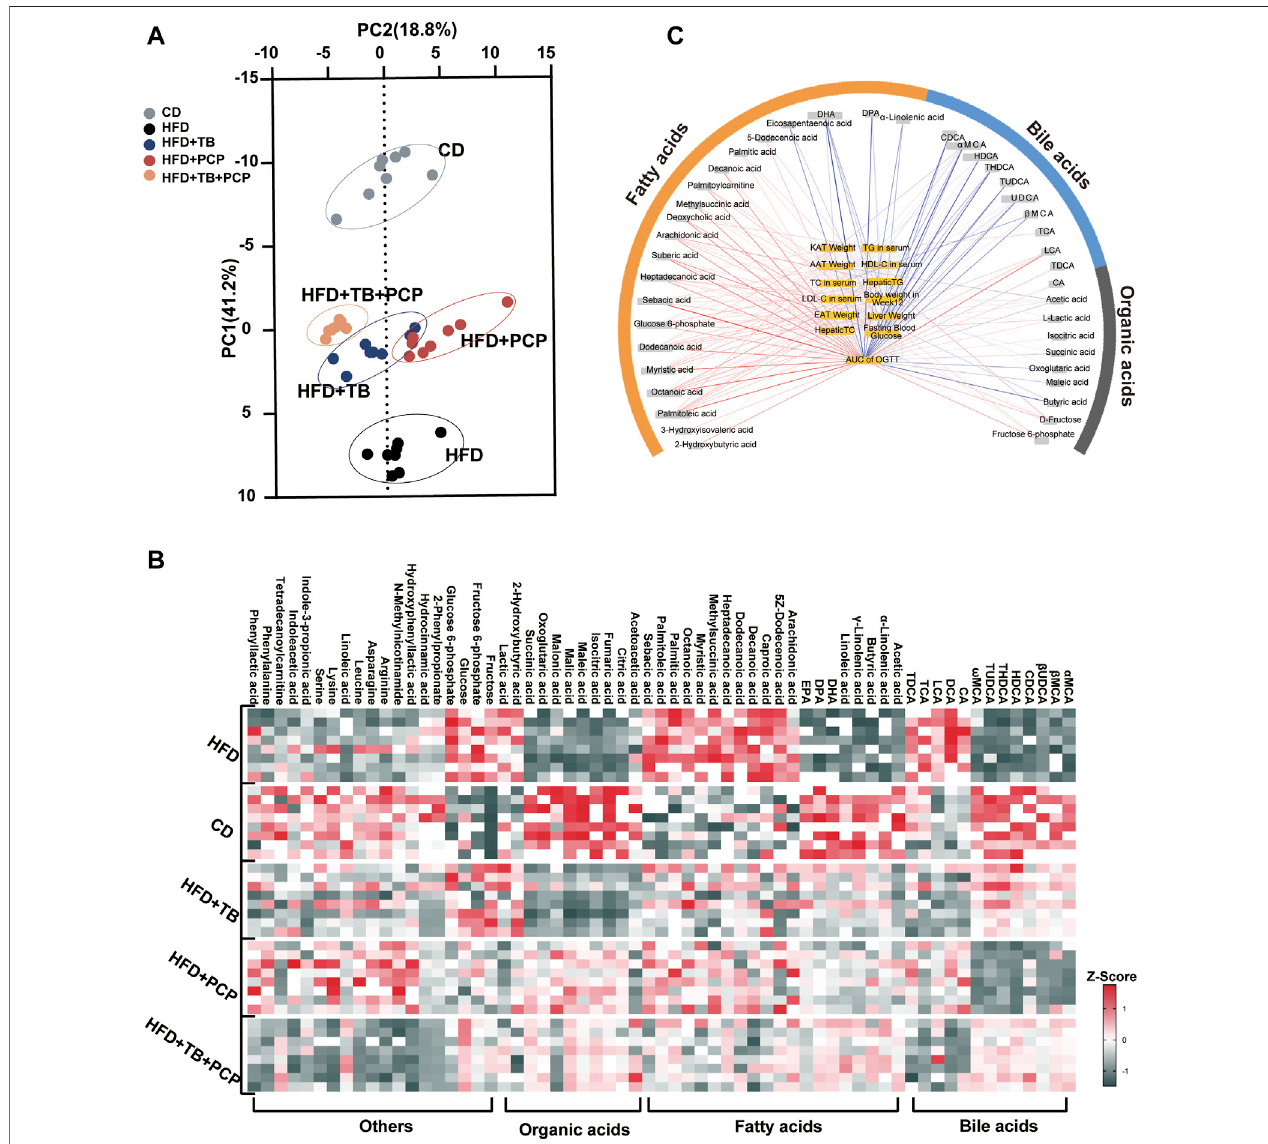
FIGURE2|(A) Partialleastsquaresdiscriminantanalysis(PLS-DA)forCD,HFD,HFD+TB,HFD+PCP,andHFD+TB+PCPgroups. (B) Theheatmapsofserum metabolitesinthe fi vegroups.The z- scorere fl ectsthenumberofstandarddeviationsfromthemeanforeachmetabolite. (C) Networkintegratingphenotype – metabolite correlations. Phenotypes are shown in yellow and signi fi cant correlative metabolites are shown in gray. Red and blue lines represent positive and negative correlations, respectively. The thickness of the line represented the strength of the correlation.